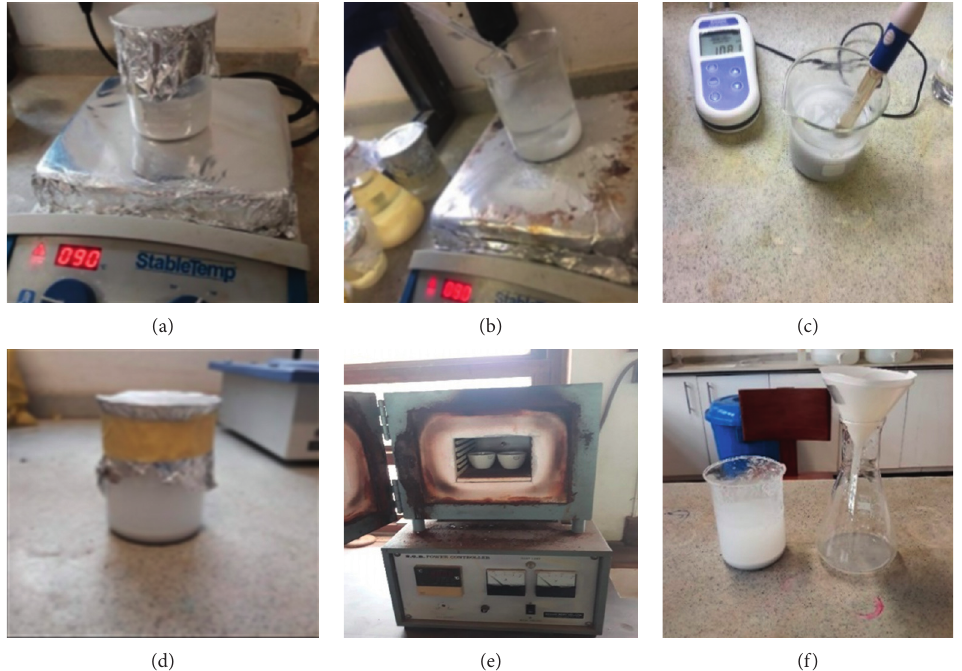
Figure 2: Steps in the preparation of HAP from calcined powdered eggshells. (a) Heating and stirring. (b) Acid addition. (c) pH measurement. (d) Aging. (e) Calcination. (f)